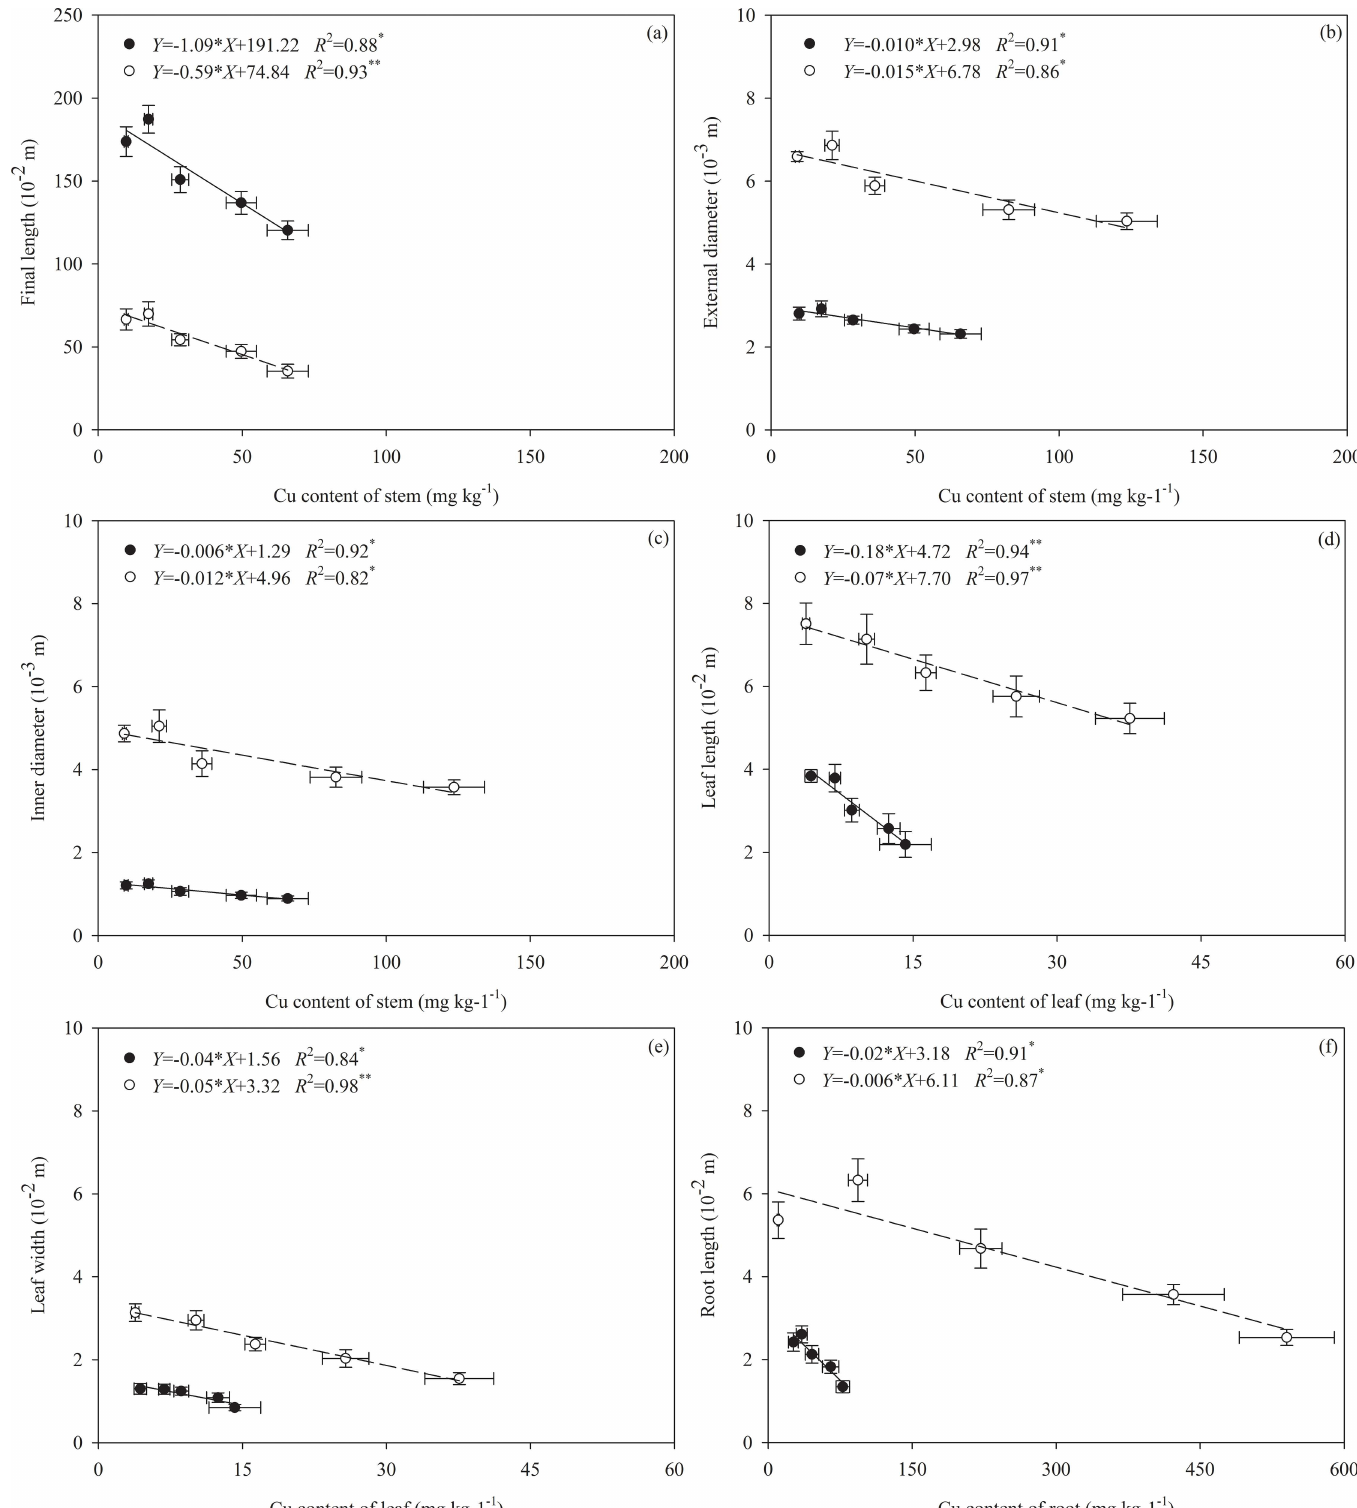
Fig 2. Relationships among the Cu content of the stem and the final length (a), external diameter (b), and inner diameter (c); Cu content of the leaf and the leaf length (d) and leaf width (e); and Cu content of the root and the root length (f) of Alternanthera philoxeroides in terrestrial habitats (black circles;